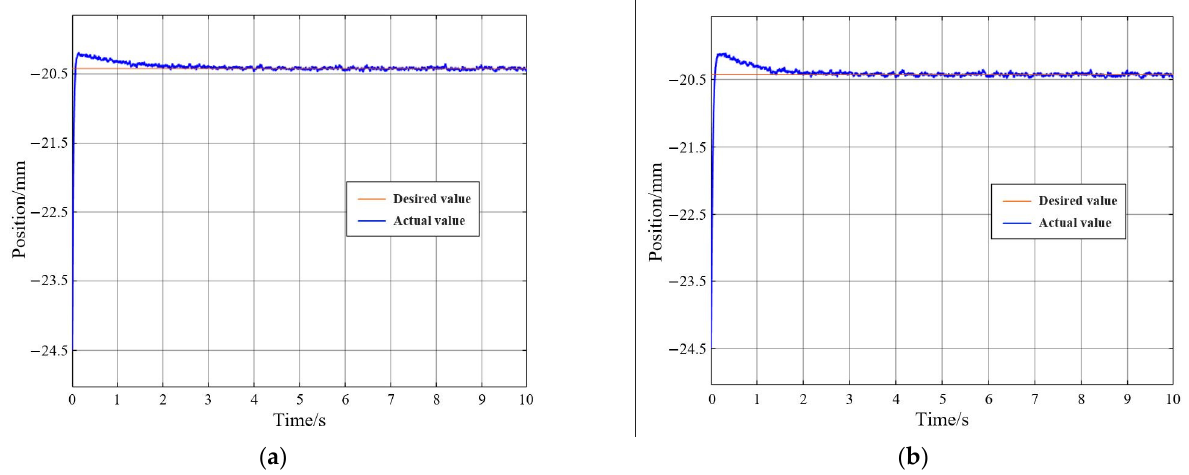
Figure 8. Step response position tracking of the test of different controller with the same electromagnetic actuation structure. ( a ) Neuron network PID controller; ( b ) Model-based controller.